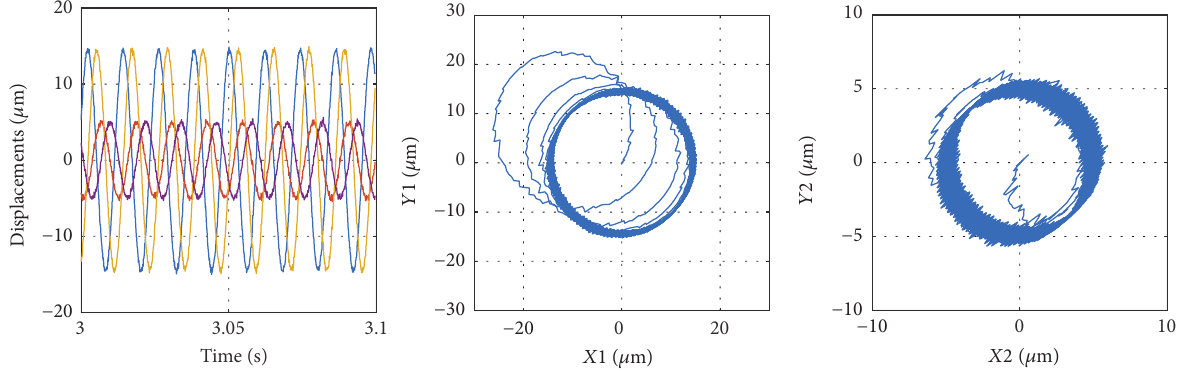
Figure 8: Unbalance responses of the closed-loop AMB system.